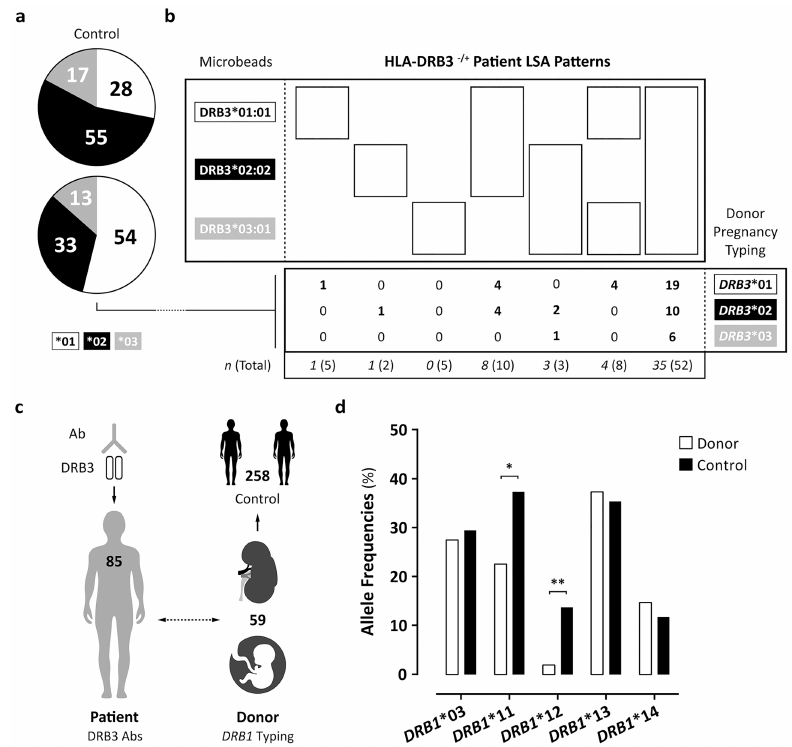
Fig 3. The immunologic events of HLA-DRB3 (cid:3) 01, (cid:3) 02, (cid:3) 03 and the allele frequencies of HLA-DRB1 in the donors. a, b. The immunologic events defined as the HLA-DRB3 ( (cid:3) 01, (cid:3) 02, (cid:3) 03) typing of the graft donors or children (pregnancies) and the reactivity patterns of HLA-DRB3 antibodies against LSA microbeads HLA-DRB3 (cid:3) 01:01, (cid:3) 02:02, and (cid:3) 03:01 that were detected in HLA-DRB3 negative and positive kidney patients ( n = 52). The percentages of the patients’ LSA reactivity pattern that correspond with the HLA-DRB3 donor typing are shown in the pie chart. The distribution of the HLA-DRB3 alleles of the graft donors or children are compared with a control group ( HLA-DRB3 positive individuals without HLA-DRB3 antibodies). c. In 85 kidney patients HLA-DRB3 antibodies were detected. With respect to the donor group, 59 graft donors or children were typed for HLA-DRB1 . These HLA-DRB1 alleles (linked to HLA-DRB3 )were compared with a control group in a case-control setting. d. The allele frequencies of HLA-DRB1 (cid:3) 03, (cid:3) 11, (cid:3) 12, (cid:3) 13, and (cid:3) 14 are displayed as percentage. The difference between donor and control groups was calculated using the Chi-squared test. The P values of < 0.05 ( (cid:3) ) and < 0.01 ( (cid:3)(cid:3) ) were statistically significant.